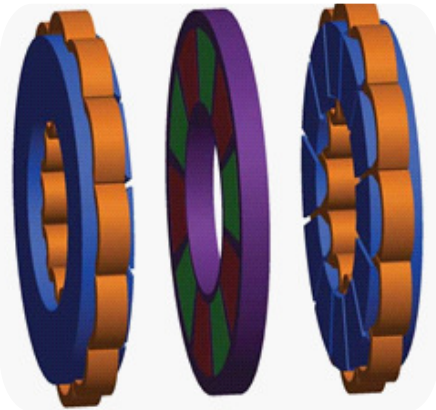
Figure 5. Double stator AFPM motor with ironless rotor structure, reprinted with permission from Ref. [38], 2022,